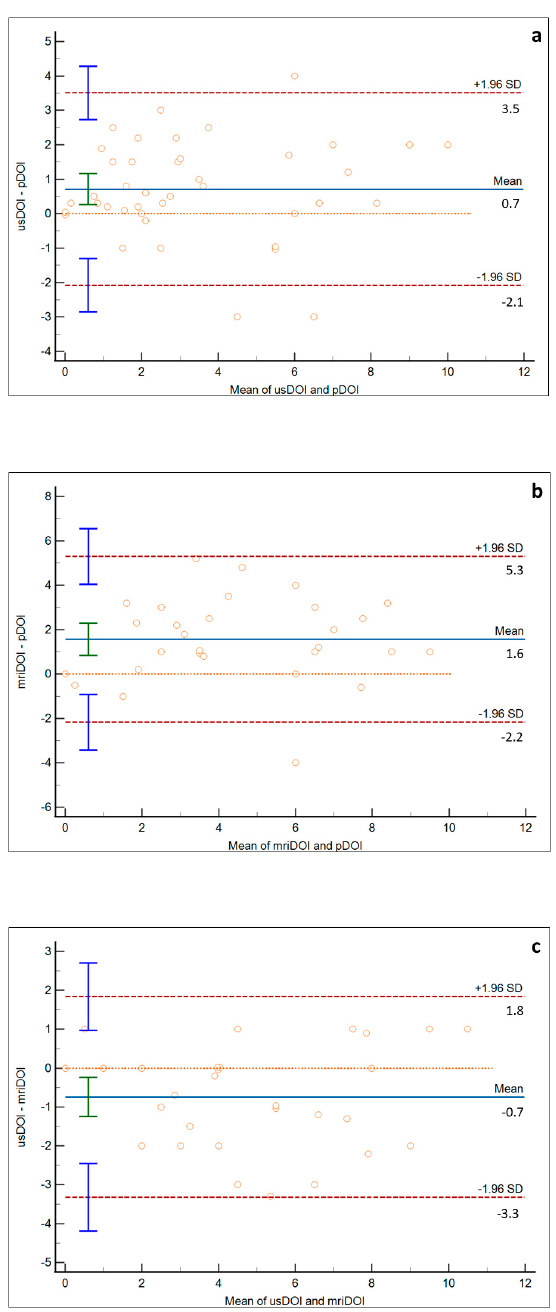
Figure 4. Bland-Altman plots comparing usDOI and pDOI ( a ), mriDOI and pDOI ( b ), and usDOI and mriDOI ( c ). Mean bias between usDOI and pDOI is 0.7 mm, between mriDOI and pDOI is 1.6 mm, and between usDOI and mriDOI is − 0.7 mm. Interval agreement is smaller in the usDOI-pDOI plot than in the mriDOI-pDOI plot (red lines: interval agreement; blue line mean difference: orange line: zero line).